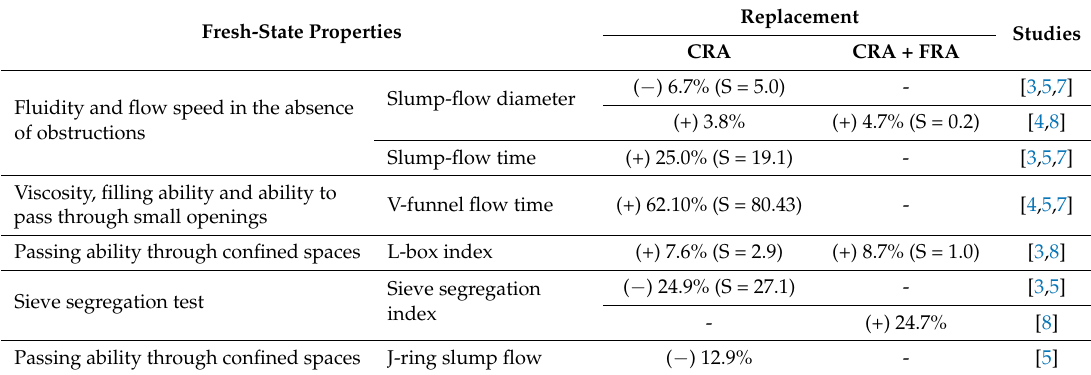
Table 1. Coarse Recycled Aggregates (CRA) and Fine Recycled Aggregates (FRA) influence on Self-Compacting Concrete (SCC) fresh-state performance in previous